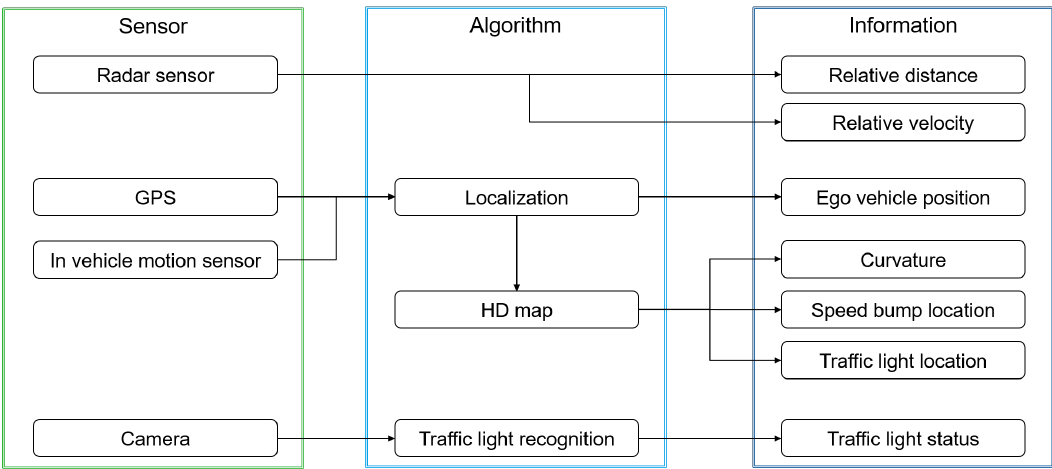
Figure 3. Intelligent Transportation System (ITS) fusion